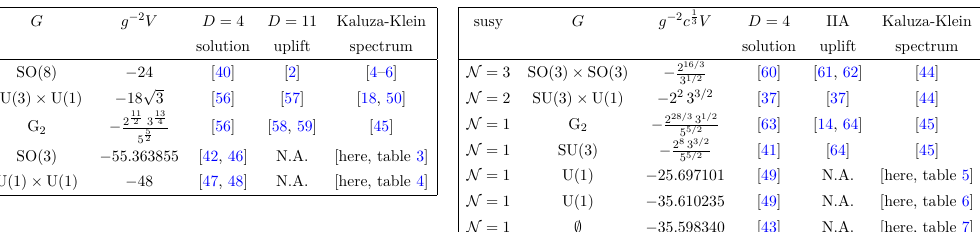
Table 1 . All known supersymmetric AdS 4 solutions that consistently uplift to D = 11 (left) and massive IIA (right) supergravities from D = 4 N = 8 supergravity with SO(8) and dyonic ISO(7) gaugings, respectively. For every solution it is shown its residual supersymmetry N , bosonic symmetry G , and D = 4 cosmological constant V in units of the gauge coupling g and dyonic parameter c (if applicable). Pointers are given to the references where the solutions were found within D = 4 and D = 11 or IIA (if available), and to their KK